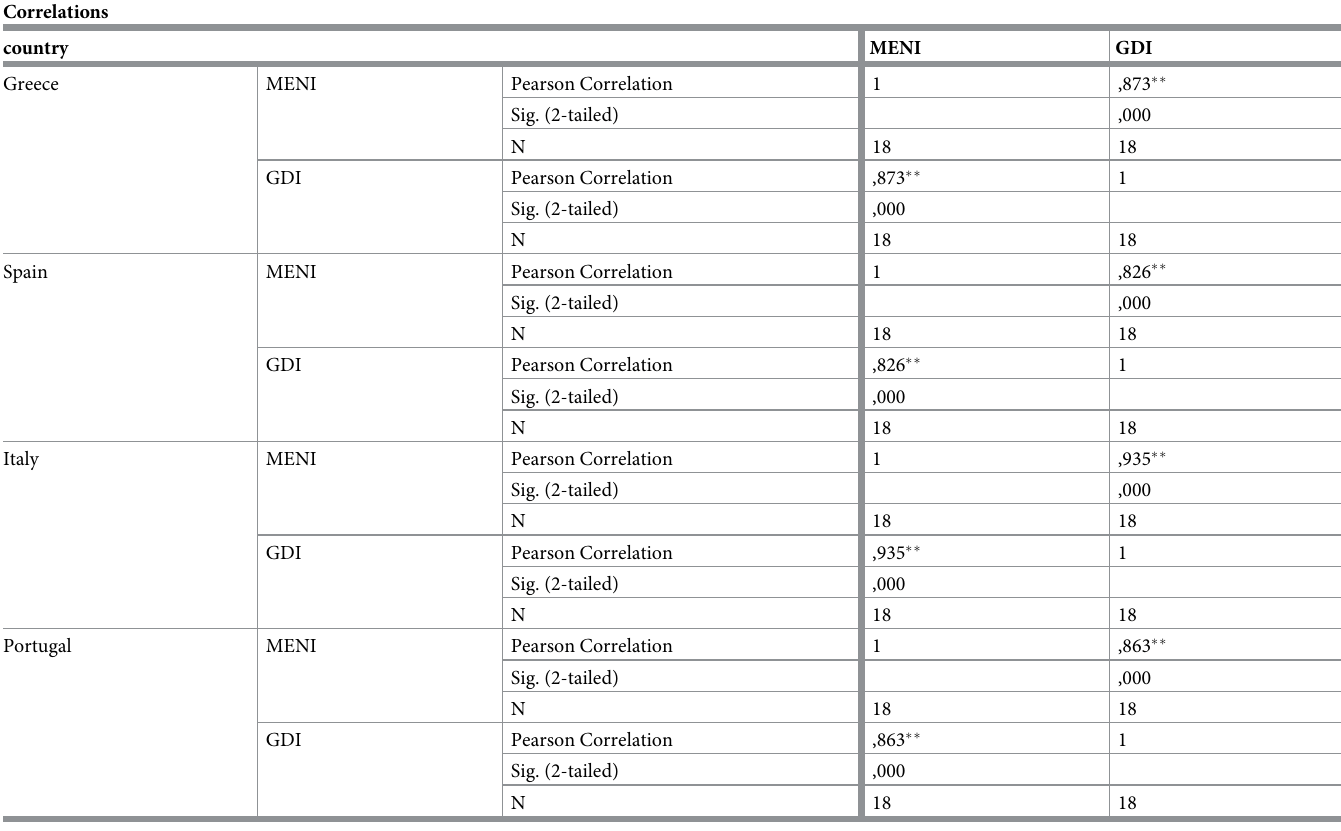
Table 4. Correlation coefficients between Equivalised Median Net Income PPP adjusted (MENI) and Gross Disposable Income per capita PPP adjusted (GDI) by country (2000–2017).